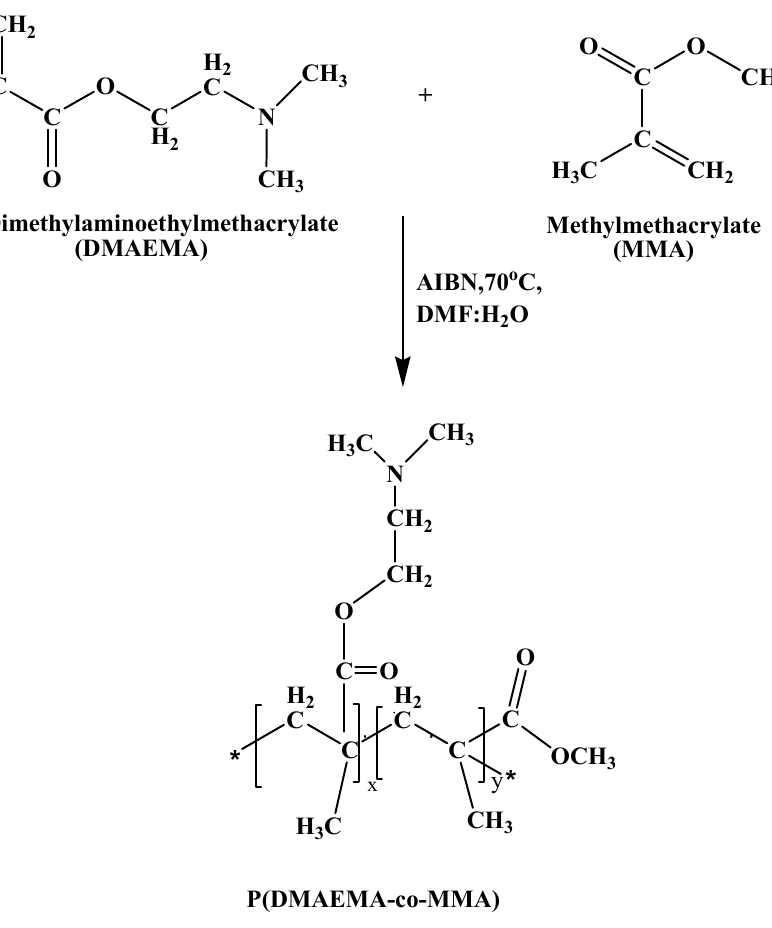
Figure 3. Schematic view of copolymerization reaction between both monomers DMAEMA and MMA.